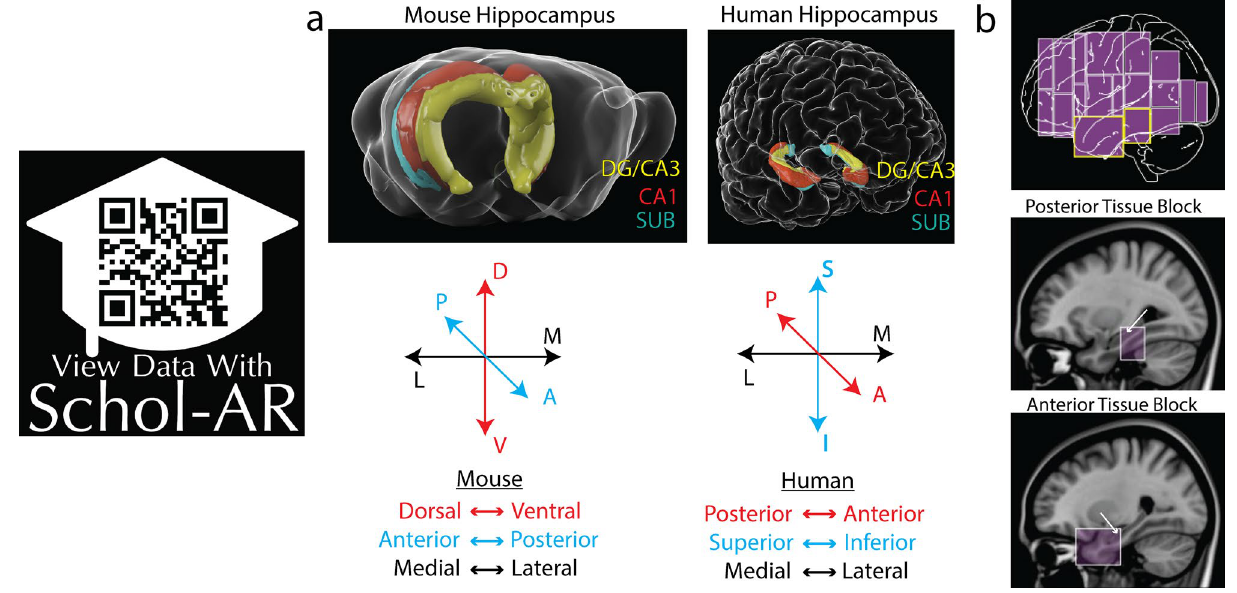
Figure 1. Structural comparison of the mouse and human hippocampus. ( a ) Three-dimensional representations of the mouse and human hippocampus showing the relative locations of the DG/CA3 (yellow), CA1 (red), and SUB (green); see also Supplementary Movie 1 or use Schol-AR app). The longitudinal hippocampal axis (red in axes chart) in mouse is oriented dorsoventrally, whereas the human longitudinal axis is rotated into the anterior–posterior axis. In addition the anterior/posterior (septo-temporal; blue color) axis in mice is oriented in the superior-inferior direction in humans. ( b ) Sagittal view of human brain volume representing the spatial location of all in situ hybridization datasets from the Allen Human Brian Atlas (top). Two tissue blocks containing posterior (middle) and anterior (bottom) parts of the hippocampus (white arrows) are shown overlaid on sagittal 3 T structural MRI images. All images in ( b ) are from www.brain -map.org. Data viewable with Schol-AR augmented reality app, for details visit https ://www.ini.usc.edu/schol ar/downl